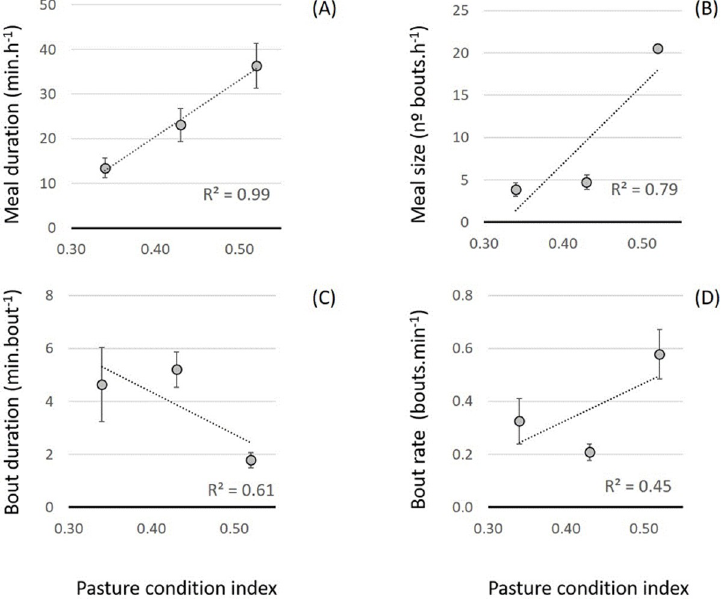
Fig 7. Relationship of structure of intake with plant growth cycle. Vegetative phase, PCi = 0.34 (n = 25; early spring 2016); reproductive phase, PCi = 0.43 (n = 25; late spring 2016); senescent phase, PCi = 0.52 (n = 9; early spring 2017). PCi = pasture condition index. (A) Meal duration; (B) meal size; (C) bout duration; (D) bout rate. The dotted trendline represents the linear estimate of the relationship (P < 0.01).